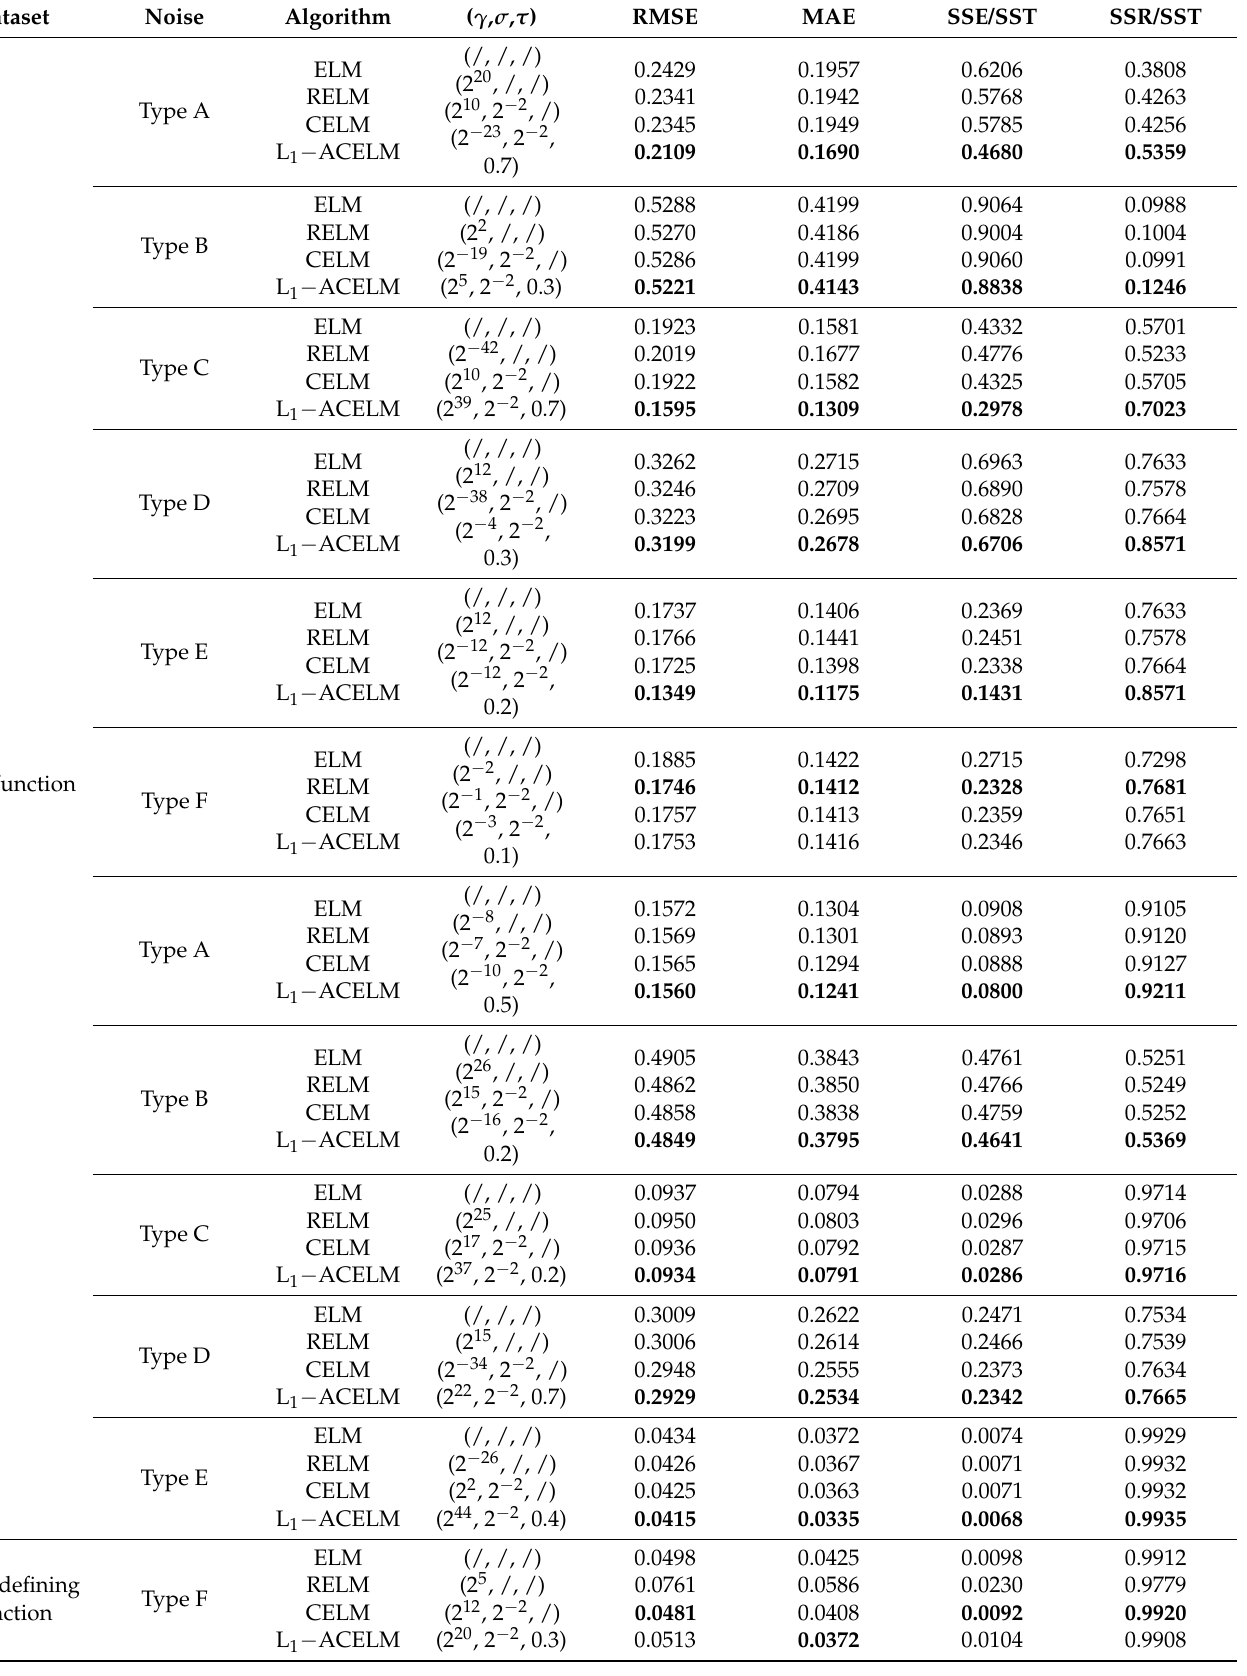
Table 2. Experiment results on artificial datasets with different types of